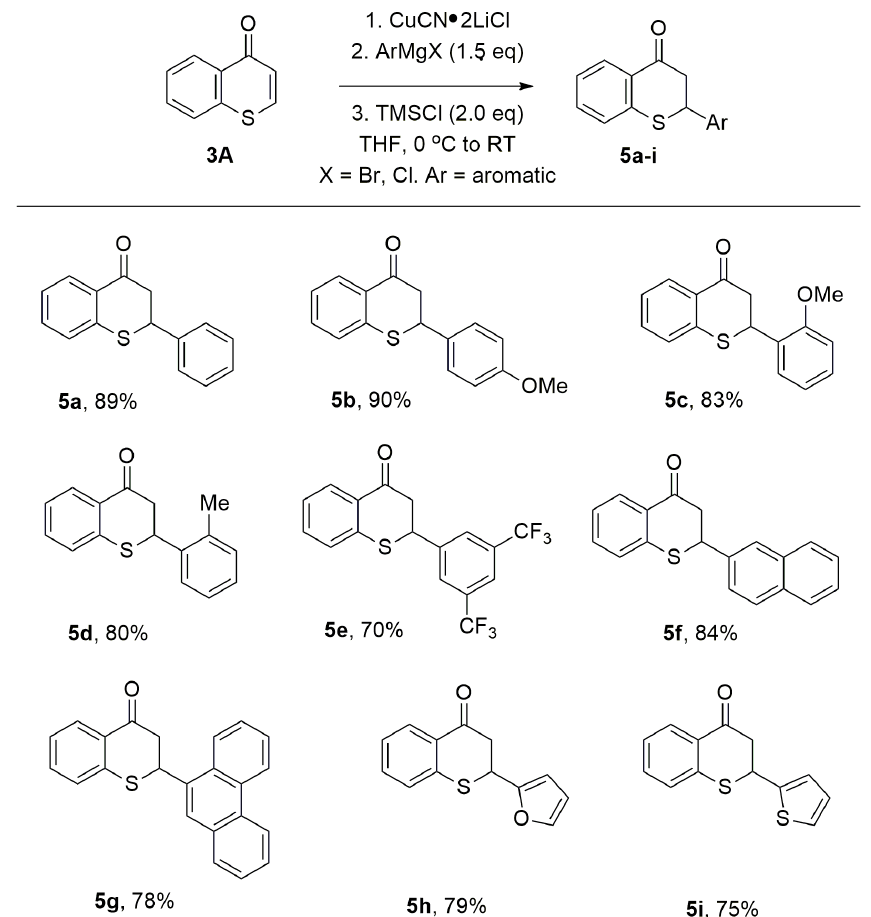
Figure 6. Copper-Catalyzed Conjugate Addition of ArMgX to Thiochromones. A broad scope of thiochromones worked well under the reported optimal reaction condition (Figure 7). It was reported that n -BuMgCl underwent 1,4-conjugate addition to thiochromones 3B – 3P smoothly (Figure 7, 4Ba – 4Oa , 73–86%). Thiochromones bearing simple alkyl groups reacted well to afford 4Ba – 4Da in good yields (80–84%). The steric hindered t -butyl group were also tolerated to afford 1,4-adduct 4Ea with 75% yield. N - BuMgCl also added to thiochromones bearing halides on the aromatic ring (i.e., F, Br, and Cl) to deliver 1,4-adducts in good yields (Figure 7). N -BuMgCl also underwent 1,4-conju- gate addition with thiochromones with two halides on the aromatic ring, such as 6,8- difluorothiochromanone and 6,8-dichlorothiochromone with good efficiency ( 4Ka , 73% and 4La , 77%, Figure 7). Thiochromones bearing electron-donating groups, such as MeO- , also worked well (Figure 7, 4Ma , 86%; 4Oa , 85%). Extended thiochromone 3P also worked well (Figure 7, 4Pa , 71%) [58].